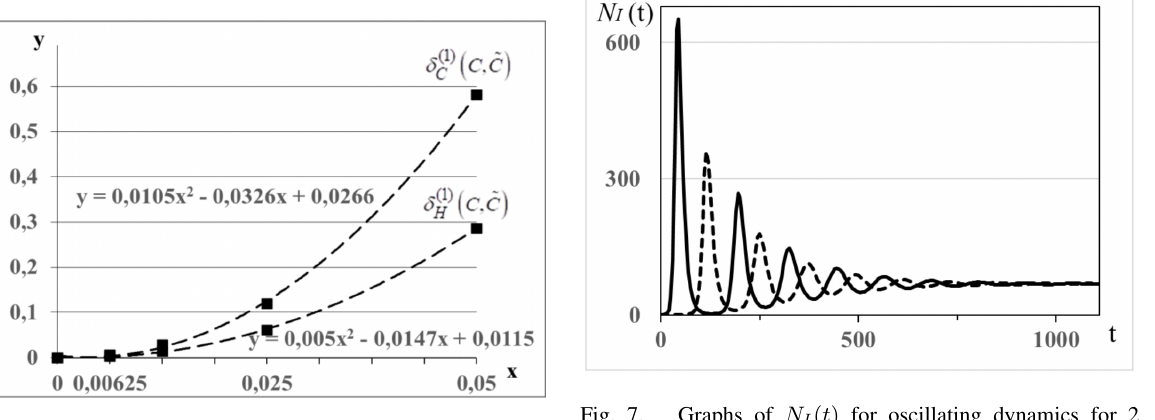
Fig. 4. (cid:4) - values of δ (1) regressions y ( x ) , x = h/a d .